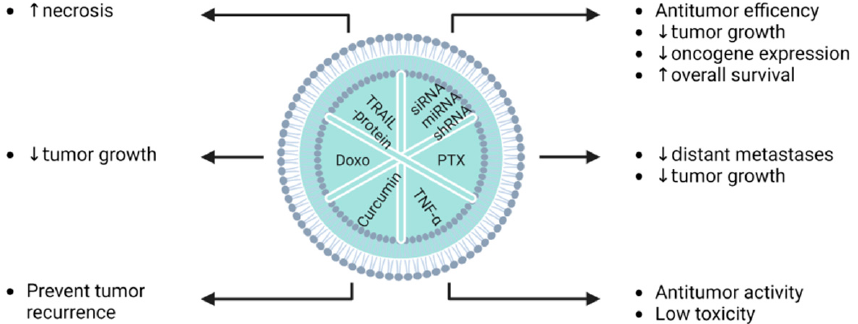
Figure 6. EV cargos and their in vivo effects on cancerous pathologies (Doxo: doxorubicin, PTX: paclitaxel, ↑ : increase, ↓ : decrease).